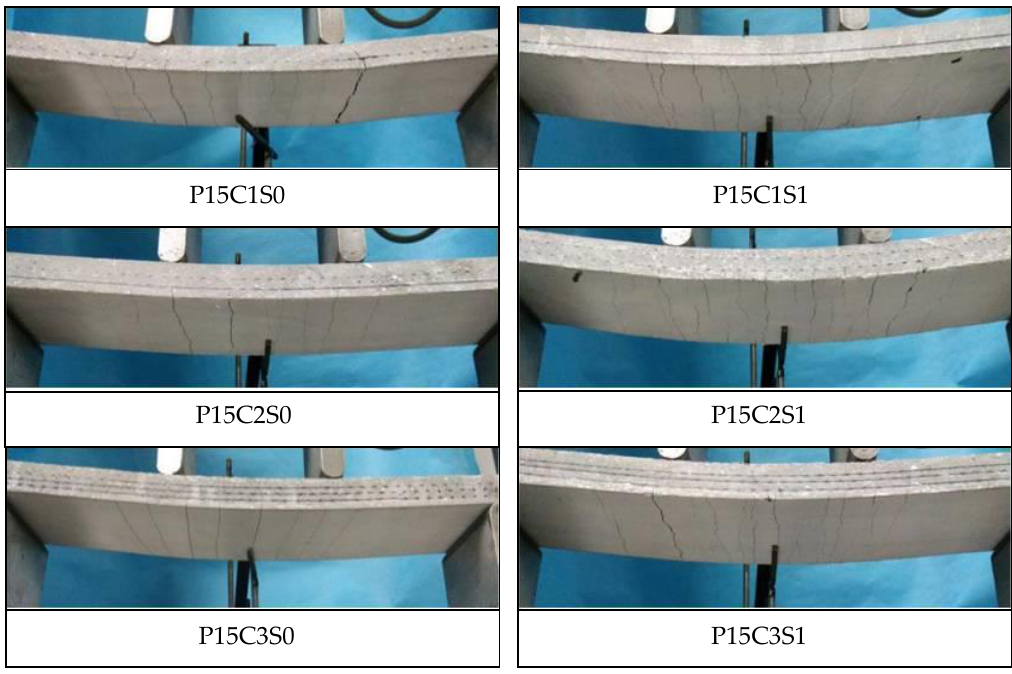
Figure 22. Crack patterns of the prestressed TRC specimens.